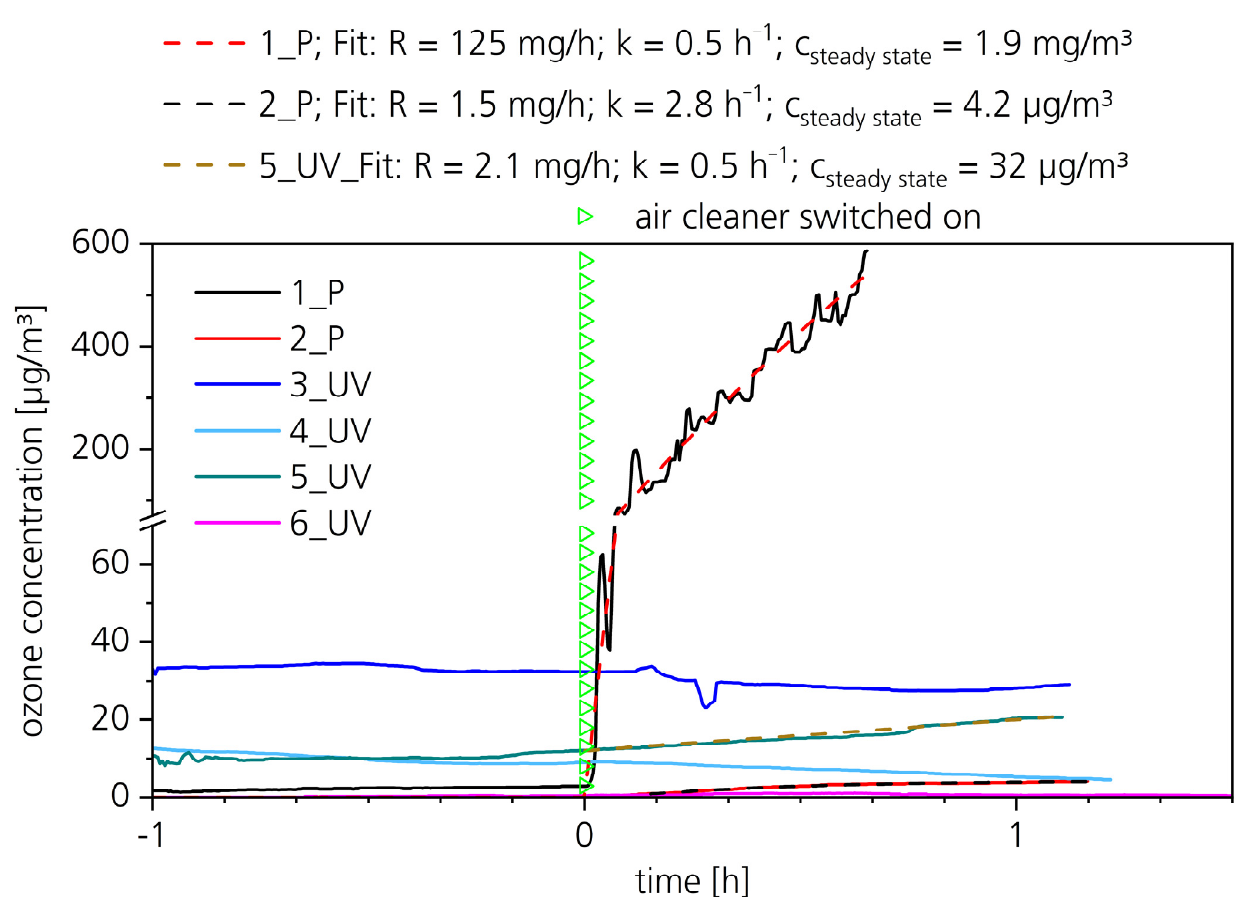
Figure 4. Ozone releases of all air cleaners. In this figure the air cleaners started at t = 0 h (green triangle). A concentration decline occurred for the air cleaners 3_UV, 4_UV, and 6_UV. For the air